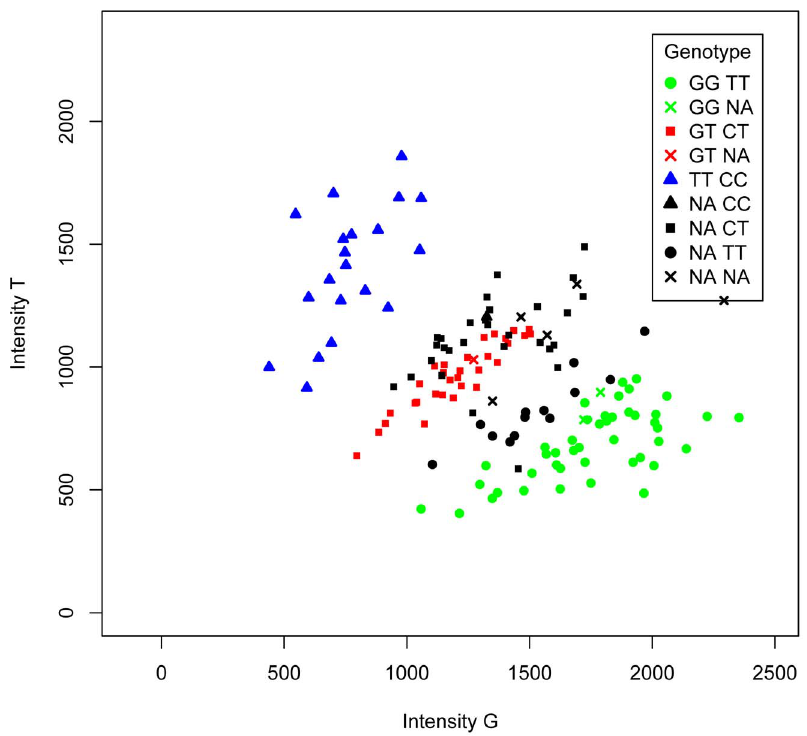
doi:10.1371/journal.pone.0083316.g004